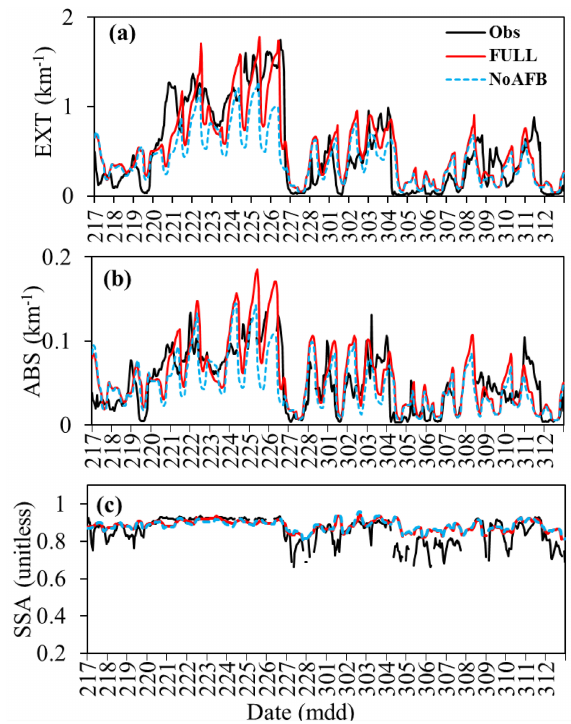
Figure 4. The model-simulated and observed hourly (a) aerosol extinction coefficient (EXT), (b) absorption coefficient (ABS), and (c) single scattering albedo (SSA) at the IAP site in Beijing under dry conditions (RH =